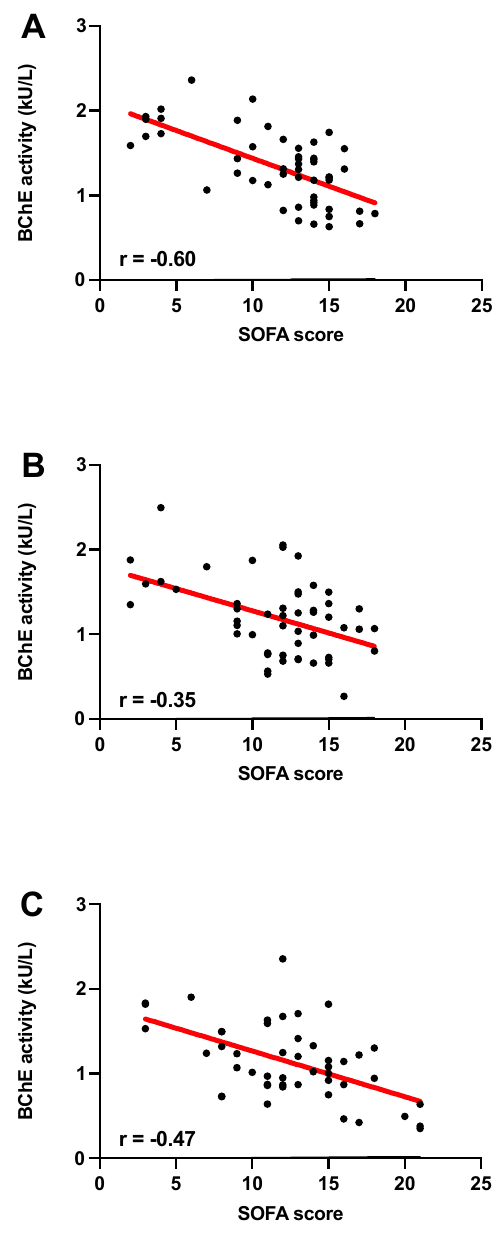
Figure 2. Correlation analysis of BChE activity with SOFA score-based assessment of disease severity in critically ill COVID-19 patients. Correlation of BChE activity with the SOFA score on day 1 (n = 52); ( A ); r = − 0.60, on day 3 (n = 52); ( B ); r = − 0.35 and on day 7 (n = 48); ( C ); r= − 0.47; p < 0.05; Spearman’s rank correlation test.